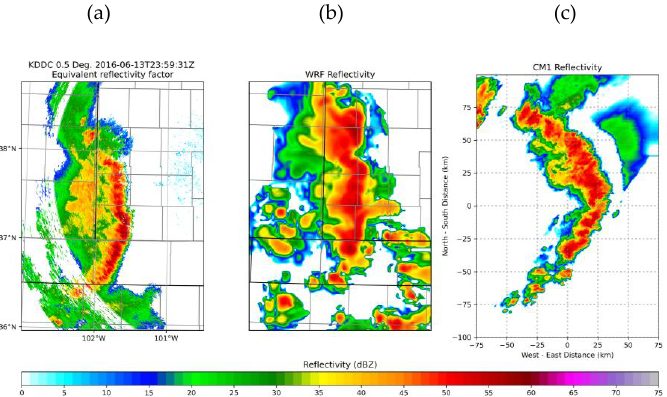
Figure 12. Skew-T/logP diagrams of baseline soundings used for initialization in the CM1 CTRL experiments in the ( a ) MCS event and ( b ) non-MCS event. For both, the surface parcel trace is given by the solid black line, with the LCL represented by the black dot. The CTRL temperature is represented by the dark red line, while SBL250 (SBL750) sounding adjustments to temperature are given by the lighter shades of red. Wind barbs in m s − 1 .